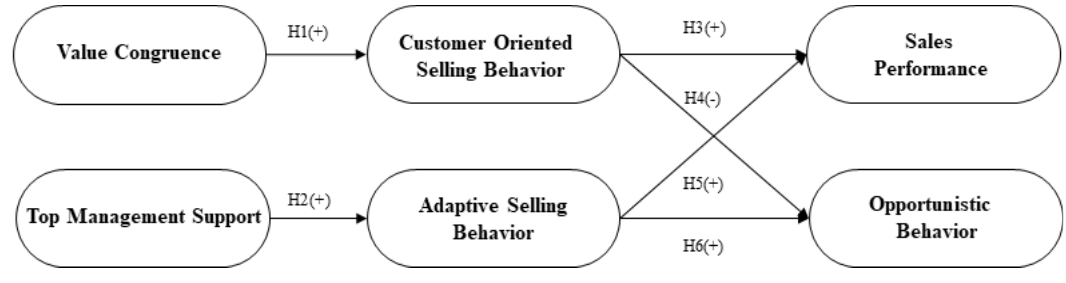
Figure 1. Conceptual